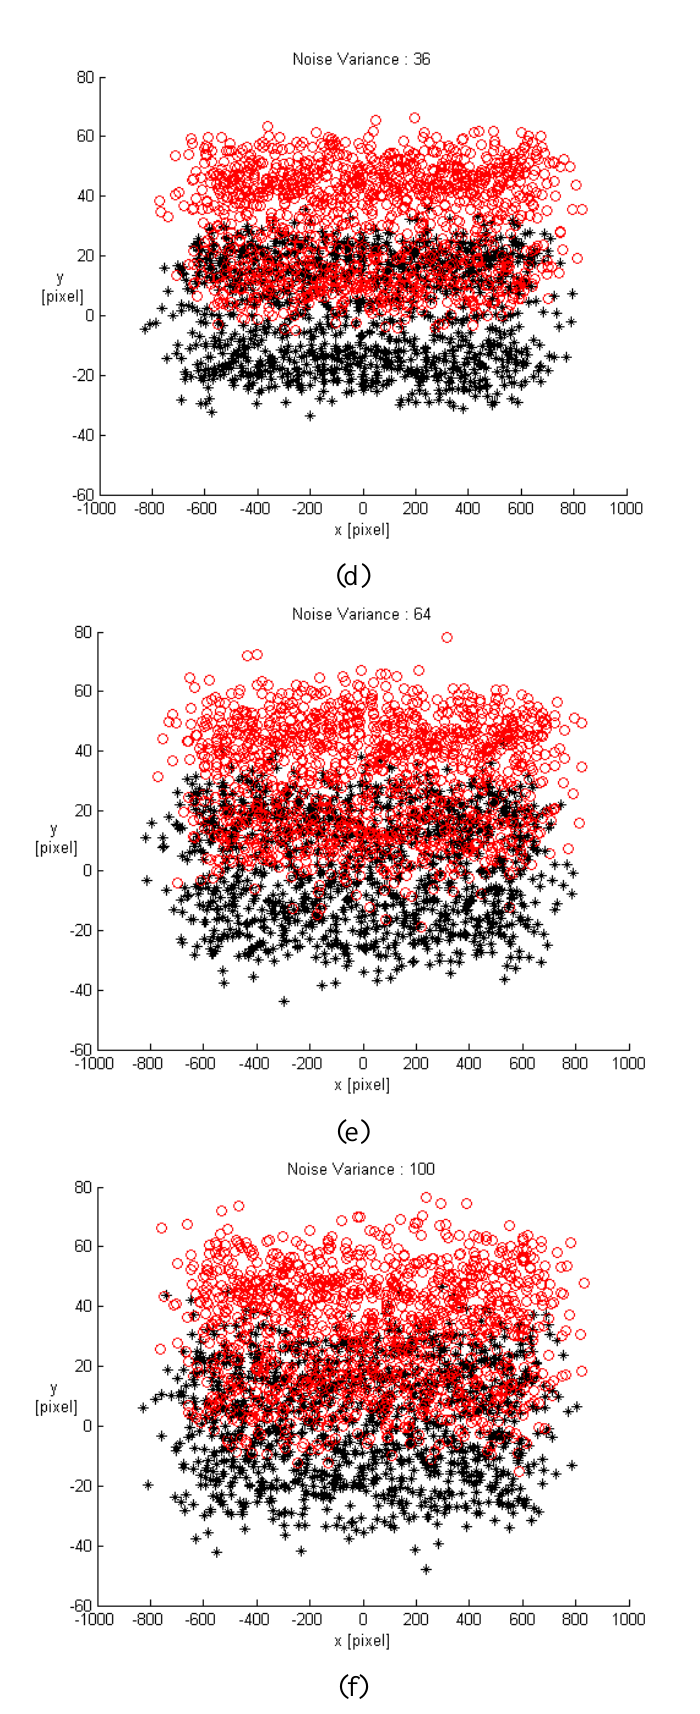
Figure 4. The image points with different noise variances for the 1×25 single-row SPCE before (black) and after (red) a